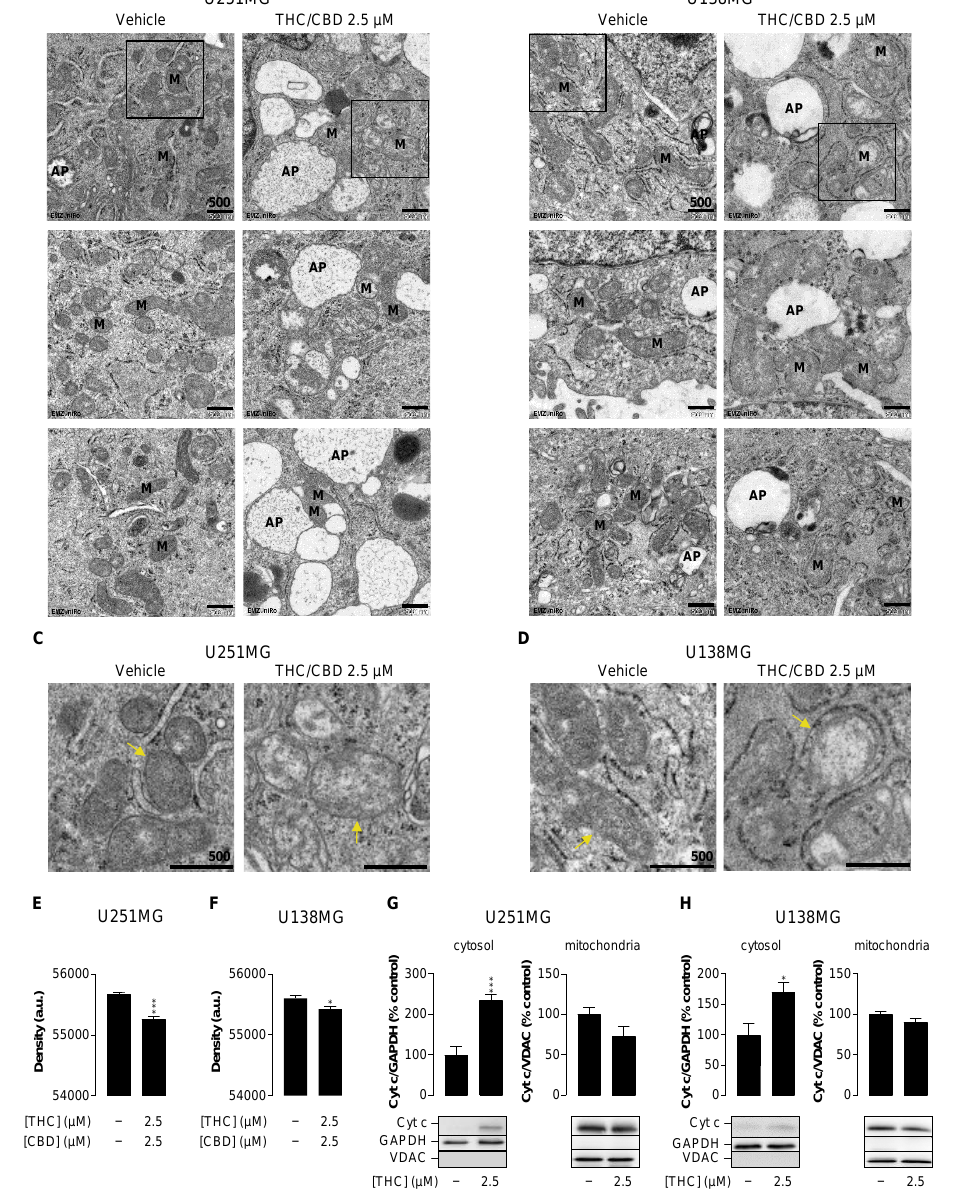
Figure 3. Influence of THC and CBD on mitochondrial structure and permeability of human glioblastoma cells. Representative images from transmission electron microscopy of U251MG ( A ) and U138MG cells ( B ) treated for 24 h with vehicle (left) or 2.5 µM THC/CBD (right). The marked structures correspond to mitochondria (M) and autophagosomes (AP), respectively. ( C , D ) are enlarged views of the outlined areas in ( A , B ), with yellow arrows indicating the mitochondria marked in the overview images. Mitochondrial density of all mitochondria per image was quantified as intensity value subtracted from maximal display value ( E , F ). Data were obtained from 7 images/108 mitochondria (vehicle), 7 images/58 mitochondria (THC/CBD, panel E ), and 11 images/115 mitochondria (vehicle) or 8 images/74 mitochondria (THC/CBD, panel F ), respectively. Cytochrome c (Cyt c) was determined by Western blot analysis in the cytosolic and isolated mitochondrial fraction ( G , H ). A representative Western blot and the quantitative analysis of n = 3–5 independent experiments are shown. The values correspond to the mean values ± SEM. * p ≤ 0.05, *** p ≤ 0.001 vs. corresponding vehicle control, unpaired two-tailed t test.